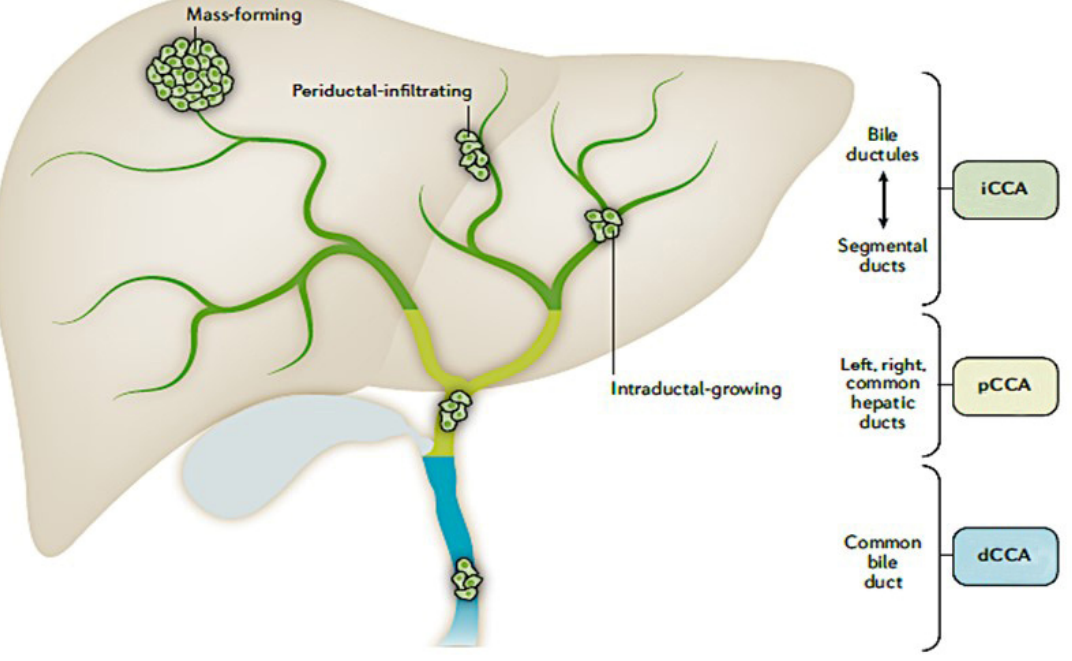
Figure 1. Location of cholangiocarcinoma within the biliary system and liver is reprinted from Banales JM et al. Nat Rev Gastroenterol Hepatol. 2020; 17: 557–588. Licensed under CC BY 4.0 (http://creativecommons.org/licenses/by/4.0/ Accessed on 2021/11/8)